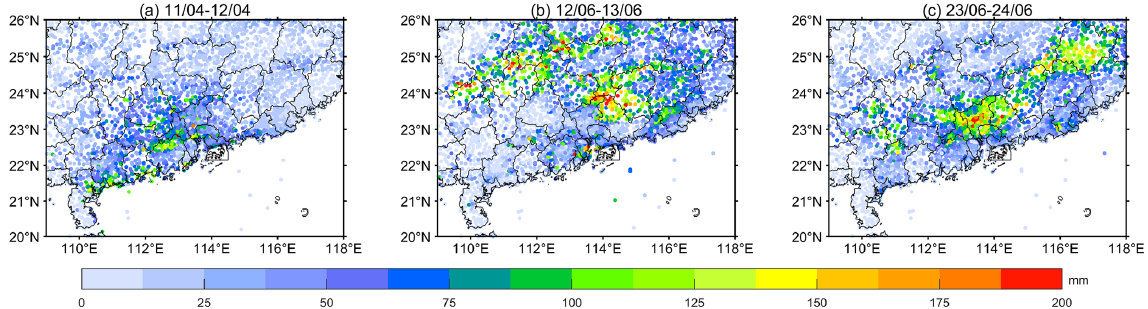
Figure 2. Spatial distribution of precipitation during the three South China rainstorms: (a) 11–12 April 2019; (b) 12–13 June 2019; (c) 23– 24 June